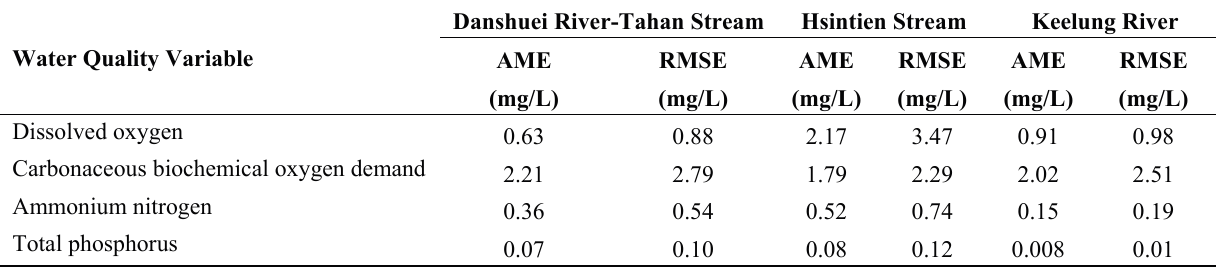
Table 6. Statistical error between simulated and measured water quality variables on 2 December